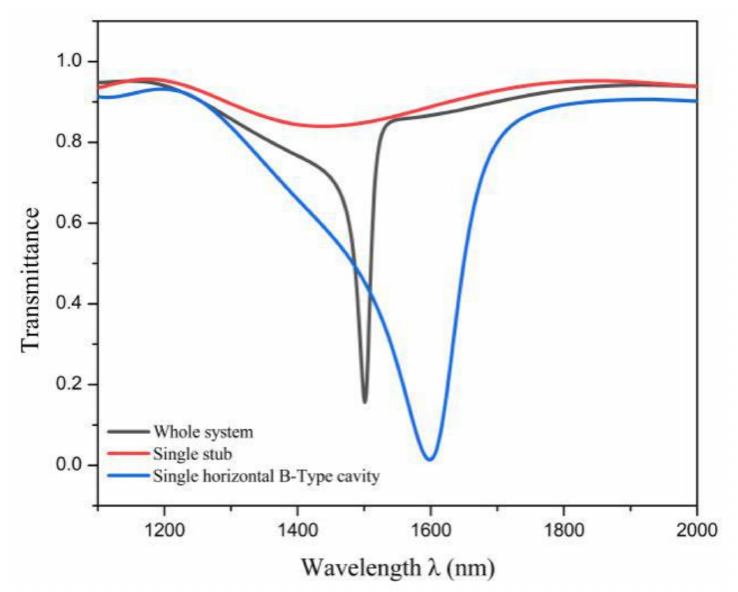
Figure 2. Transmission spectra of the whole system, the single stub and horizontal B-Type